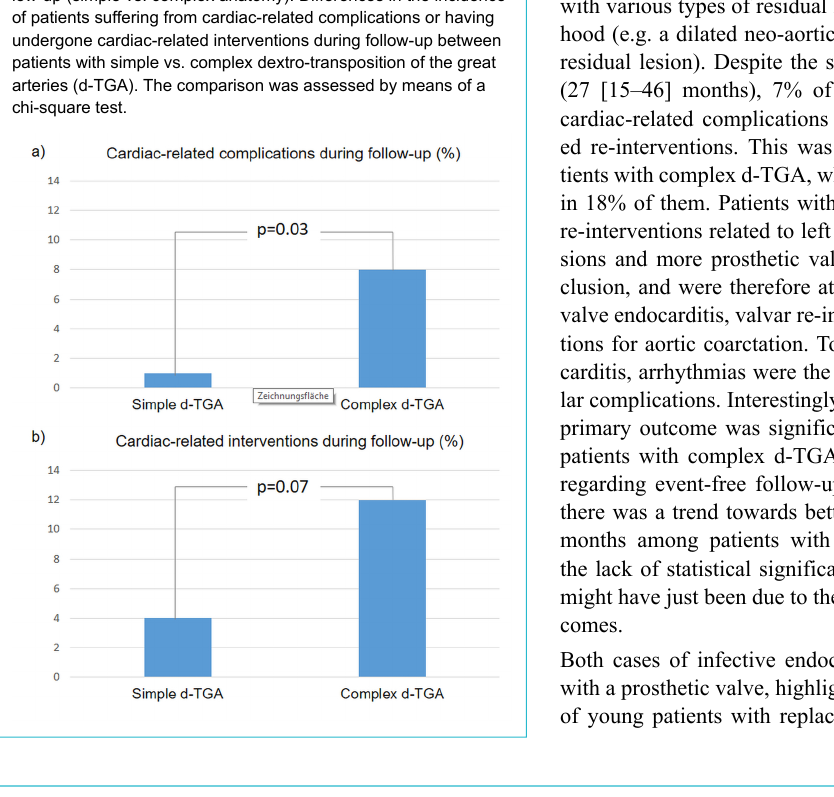
Figure 2: Survival analysis for the occurrence of the combined primary outcome in patients with simple d-TGA vs. complex d-TGA. Survival analysis for the occurrence of the combined primary outcome in patients with simple d-TGA vs. complex d-TGA at 48 months. The statistical significance of the difference between groups was assessed by means of a log-rank